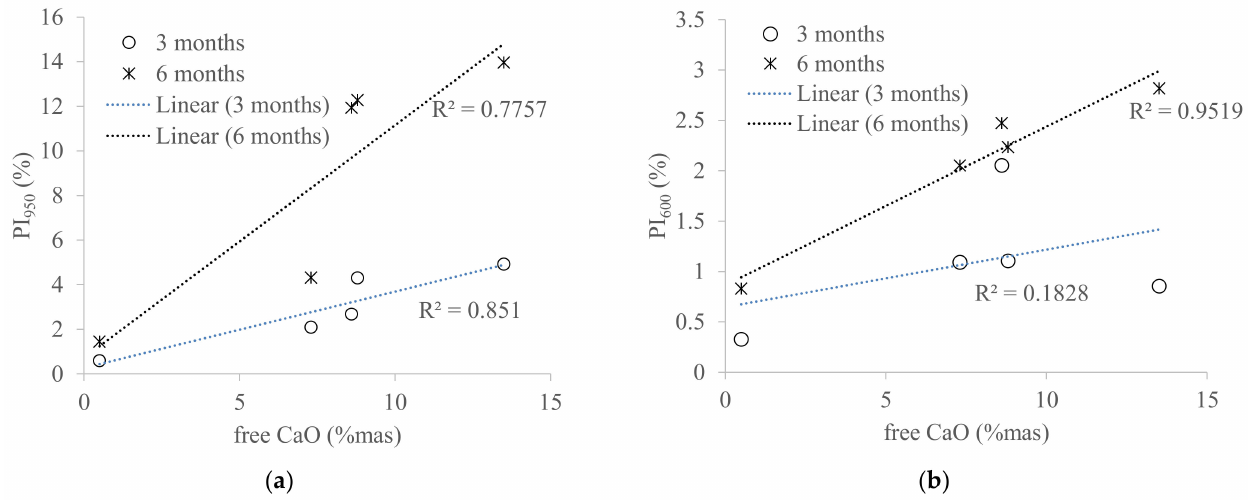
Figure 12. Effect of free CaO of WBA samples on prehydration index: ( a ) PI 950 and ( b ) PI 600